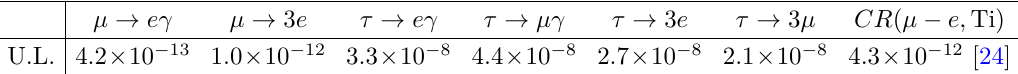
Table 3 . Current upper bounds on various LFV processes. Except for the µ − e conversion rate in titanium quoted from ref. [24], all other values are obtained from the Particle Data Group